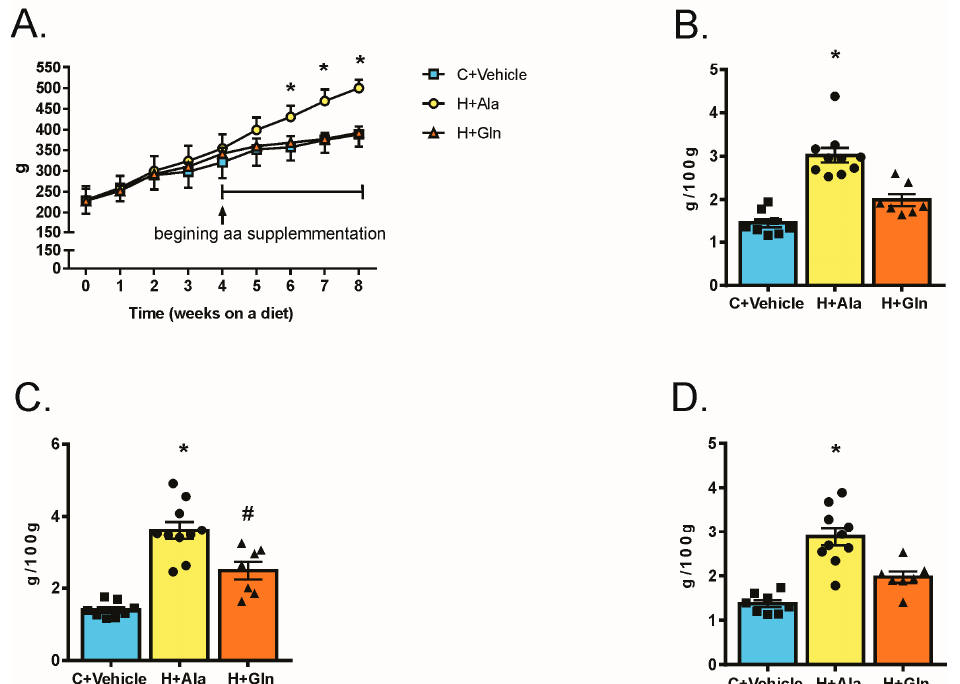
Figure 1. Positive correlation between the reduction of waist circumference (WC) and serum lipopolysaccharide (LPS) of obese and overweight humans. The Pearson Correlation test was used (r = 0.629).